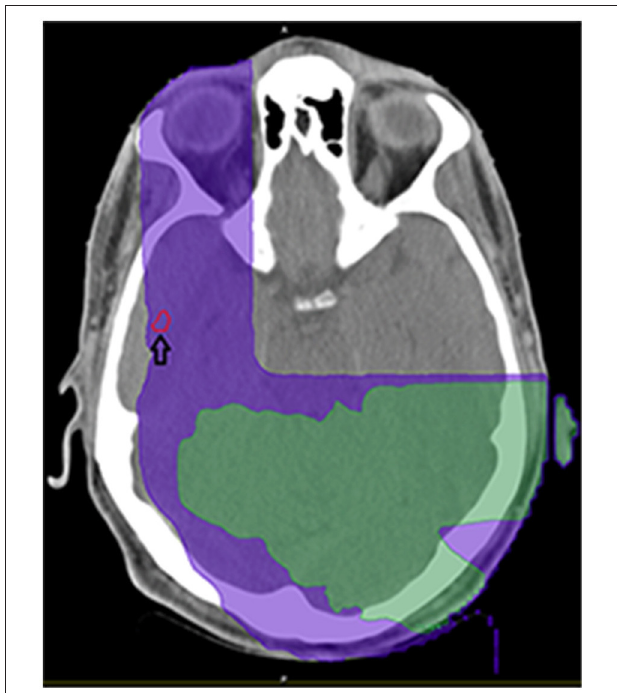
FIGURE 3 | Demonstration of isodose cloud for temporal lobe lesion (see arrow). Purple denotes 5Gy isodose; green denotes 8.57Gy isodose.